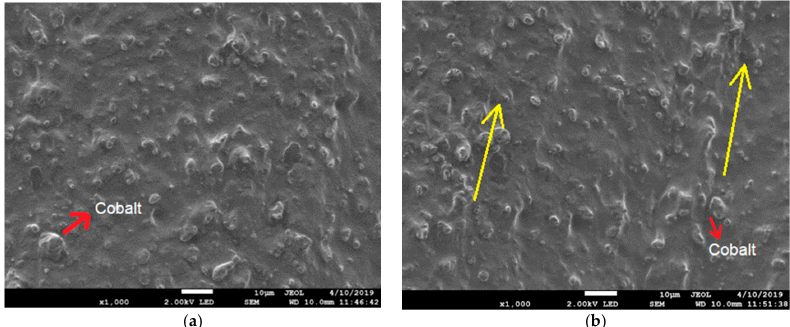
Figure 4. Field emission scanning electron microscopy (FESEM) images of ( a ) isotropic MRE and ( b ) anisotropic MRE with 53 wt % of cobalt.